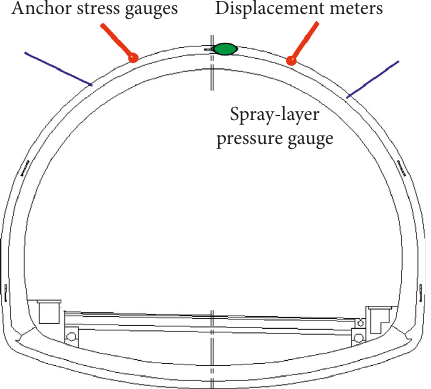
Figure 6: Section showing the arrangement of the